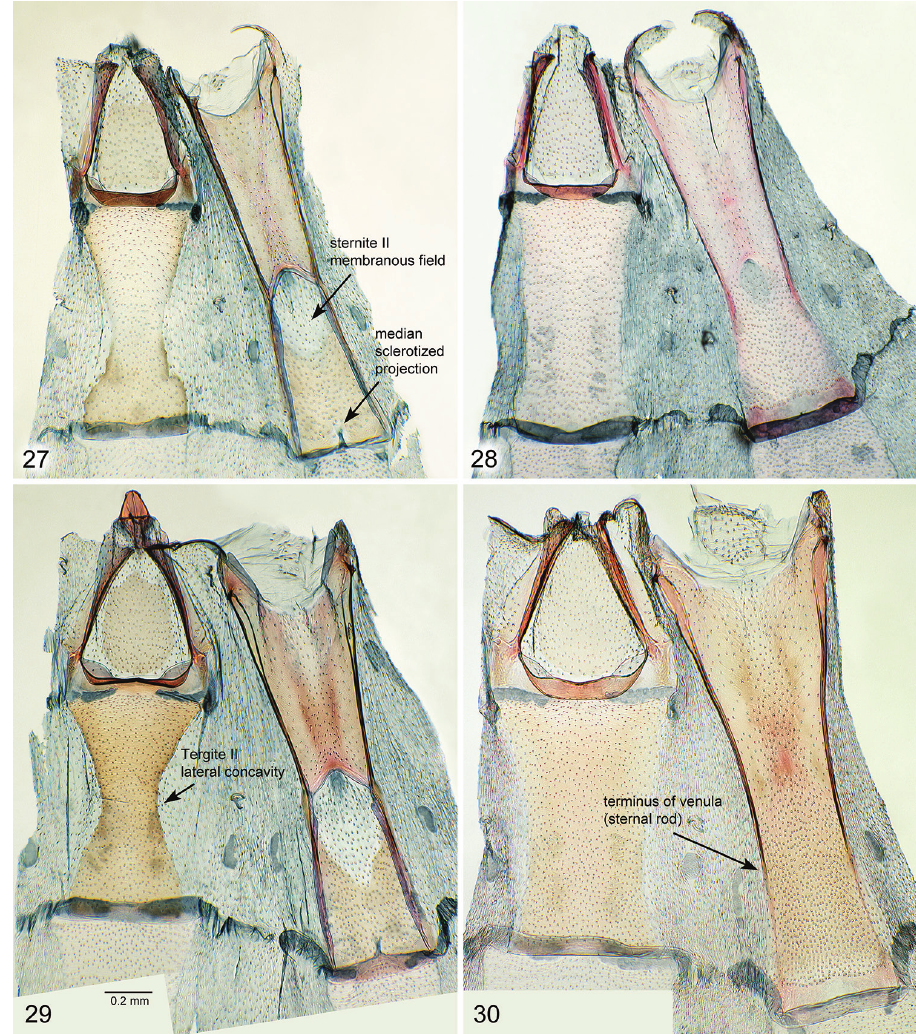
Figures 27–30. Oxyptilus abdominal segments I and II: 27 O. delawaricus male, slide DM 1837,